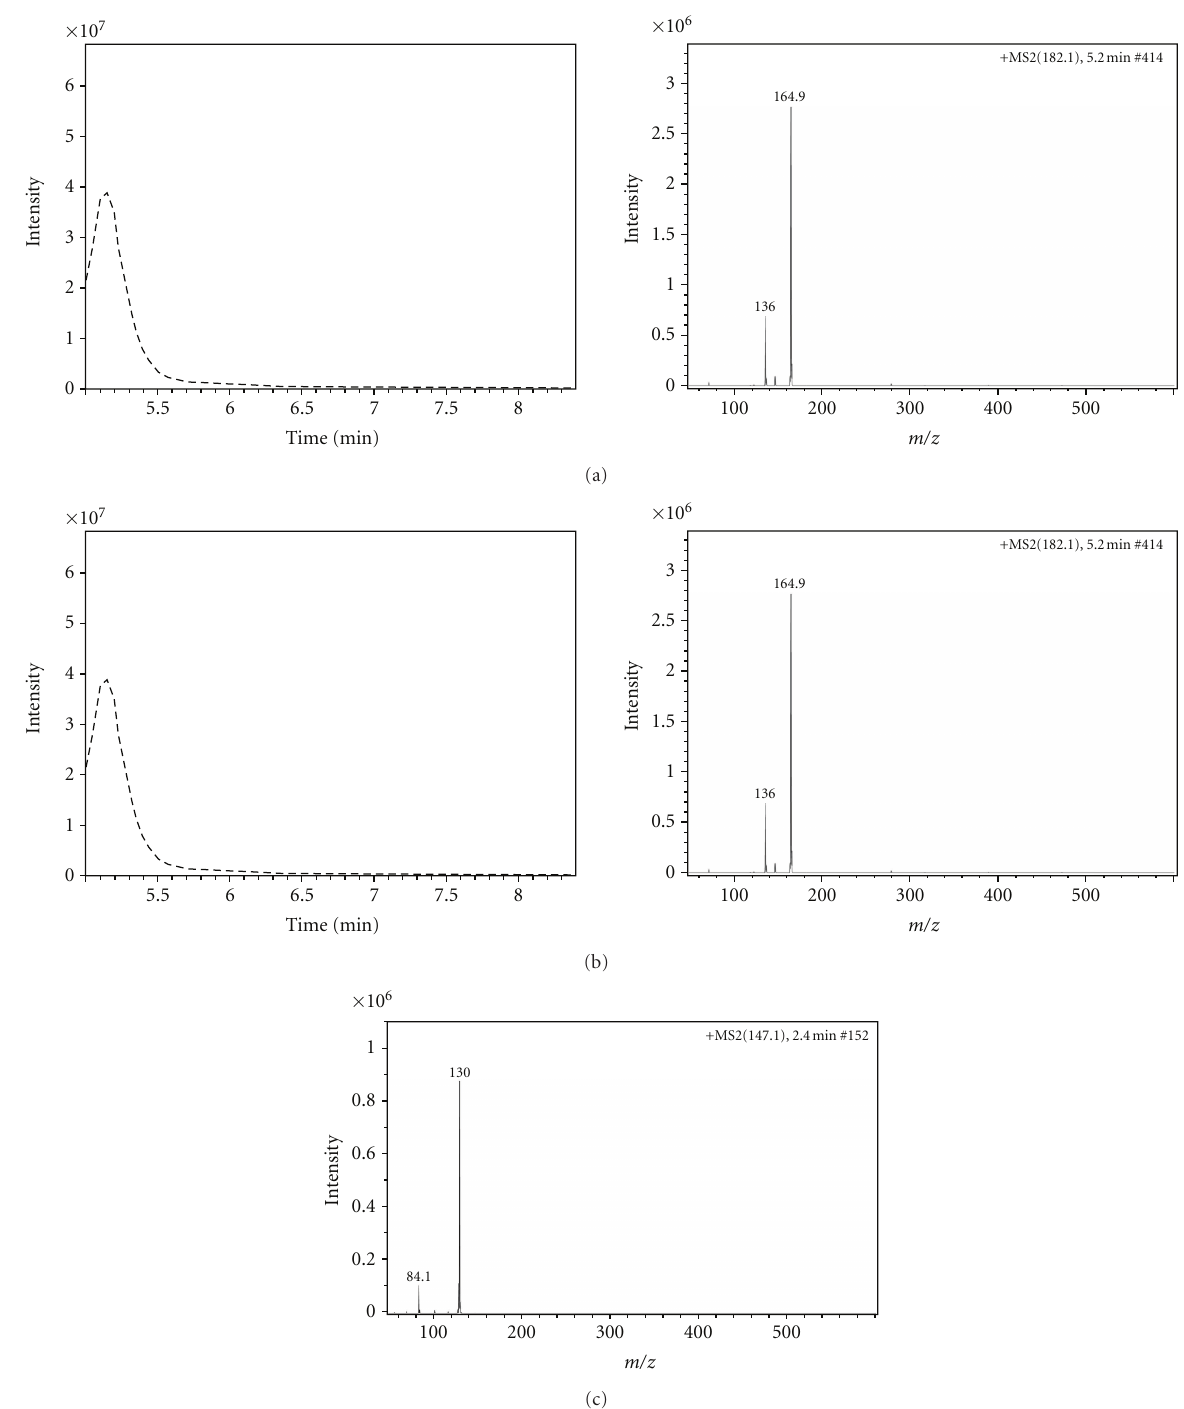
Figure 2: Mass spectrum of nontreated 1.7 PGV. (a) extraction ion current (EIC) of 120 + MS 2 (166) m/z for phenylalanine, (b) extraction ion current (EIC) of 165 + MS 2 (182) m/z for tyrosine, (c) extraction ion current (EIC) of 130 + MS 2 (147.1) m/z for glutamine.